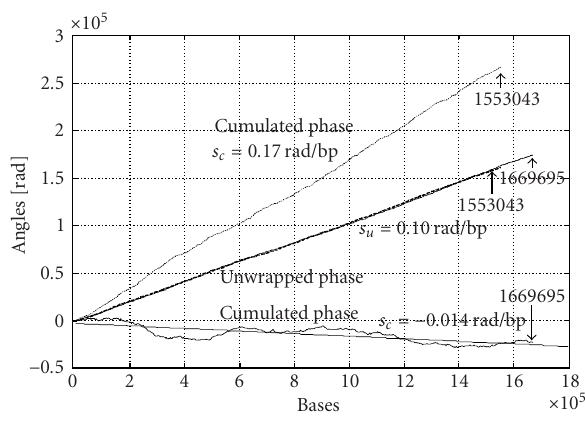
Figure 7: Cumulated and unwrapped phases of the genomic sig- nals for the complete nucleotide sequence and the concatenated reoriented coding regions of Aeropyrum pernix K genome [15] (NC000854 [12]) versus all